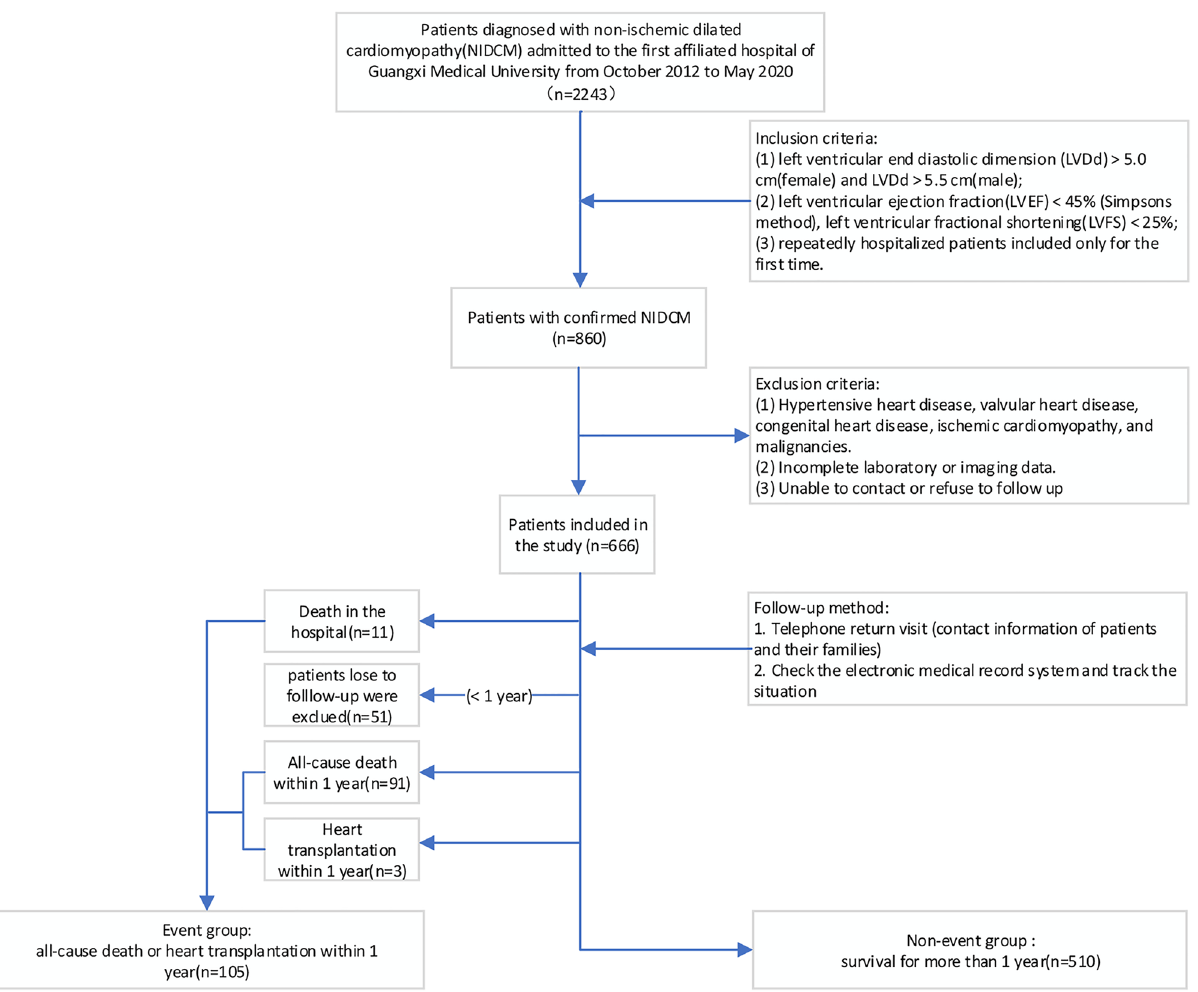
Figure 8. Flow chart showing the process of patient recruitment for the study